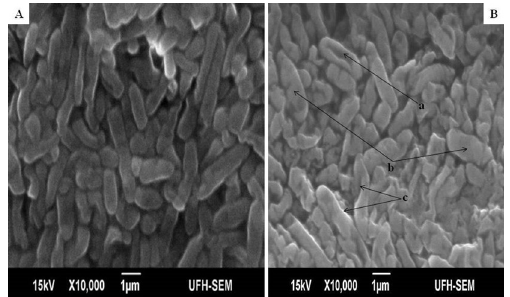
Fig. 4. Influence of ethanol extract on the morphology of B. pumilus . A = Extract untreated B. pumilus; B = Extract treated B. pumilus . (a = depressed or collapsed cell; b = swollen cells; c = collapsed cells with twisting).